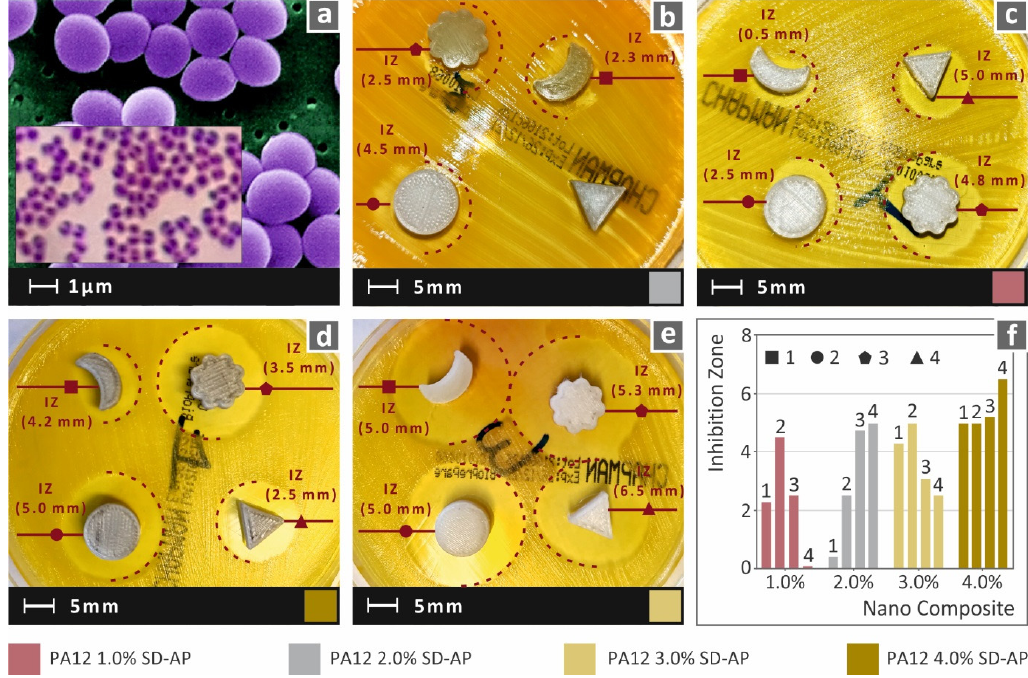
Figure 14. ( a ) Typical S. Aureus morphology; ( b – e ) lateral captures of Petri dishes and the